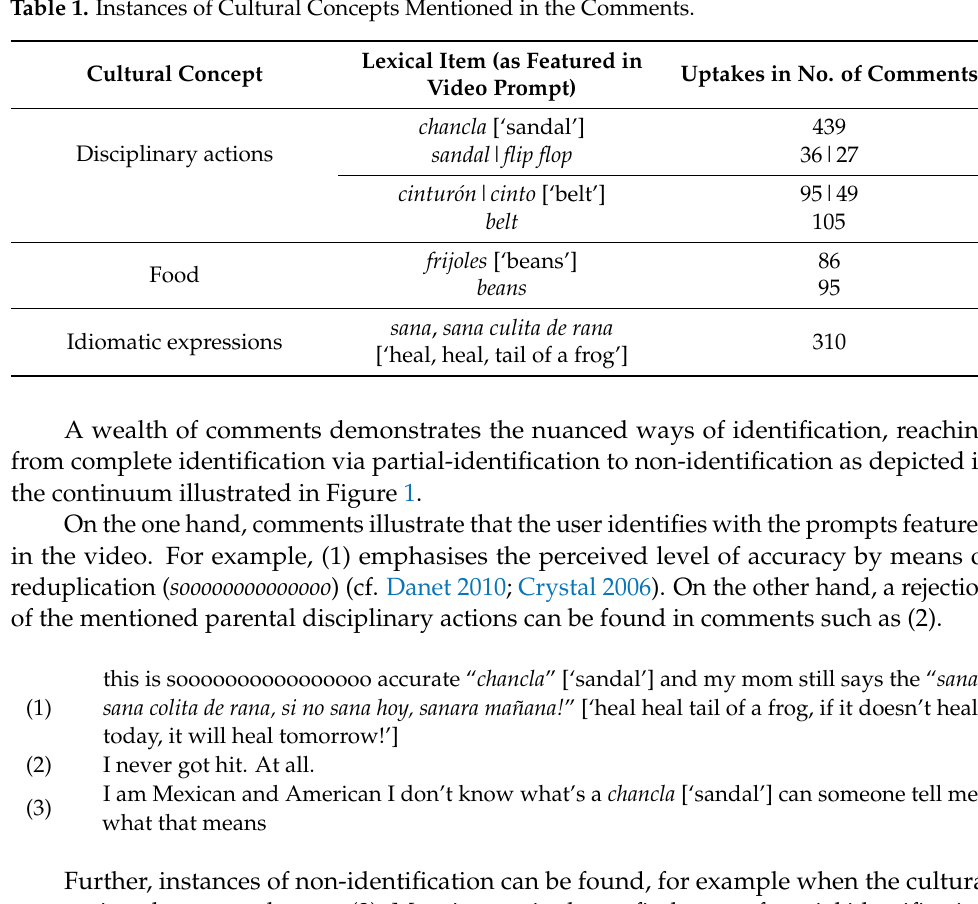
Table 1. Instances of Cultural Concepts Mentioned in the